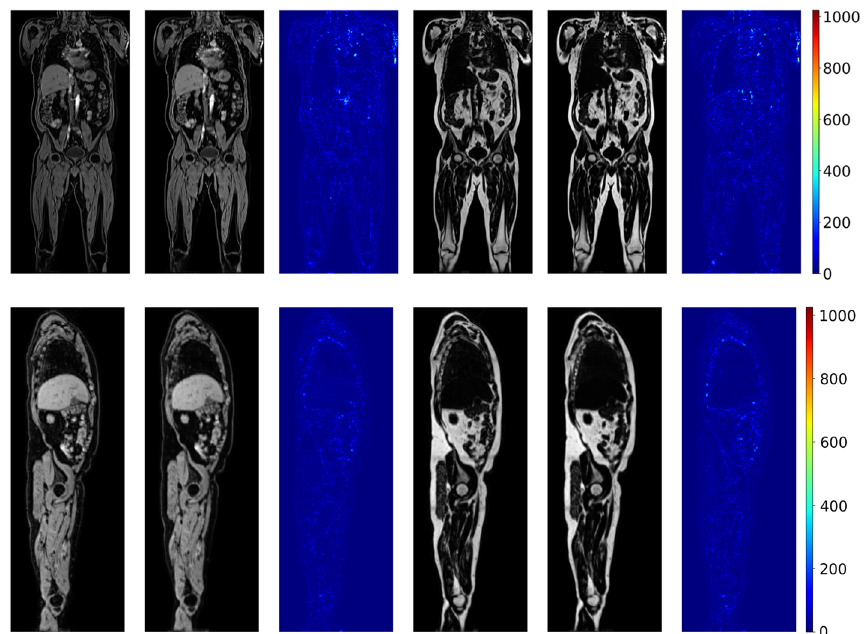
Fig. 3 Predicted values were performed on a participant in the test set, where the model was trained on all 800 participants in the training set. Absolute differences are displayed in the original image intensities. Performance metrics calculated on the 3D volume are: SSIM W = 0.953 , SSIM F = 0.970 , PSNR W = 29.80dB and PSNR F =